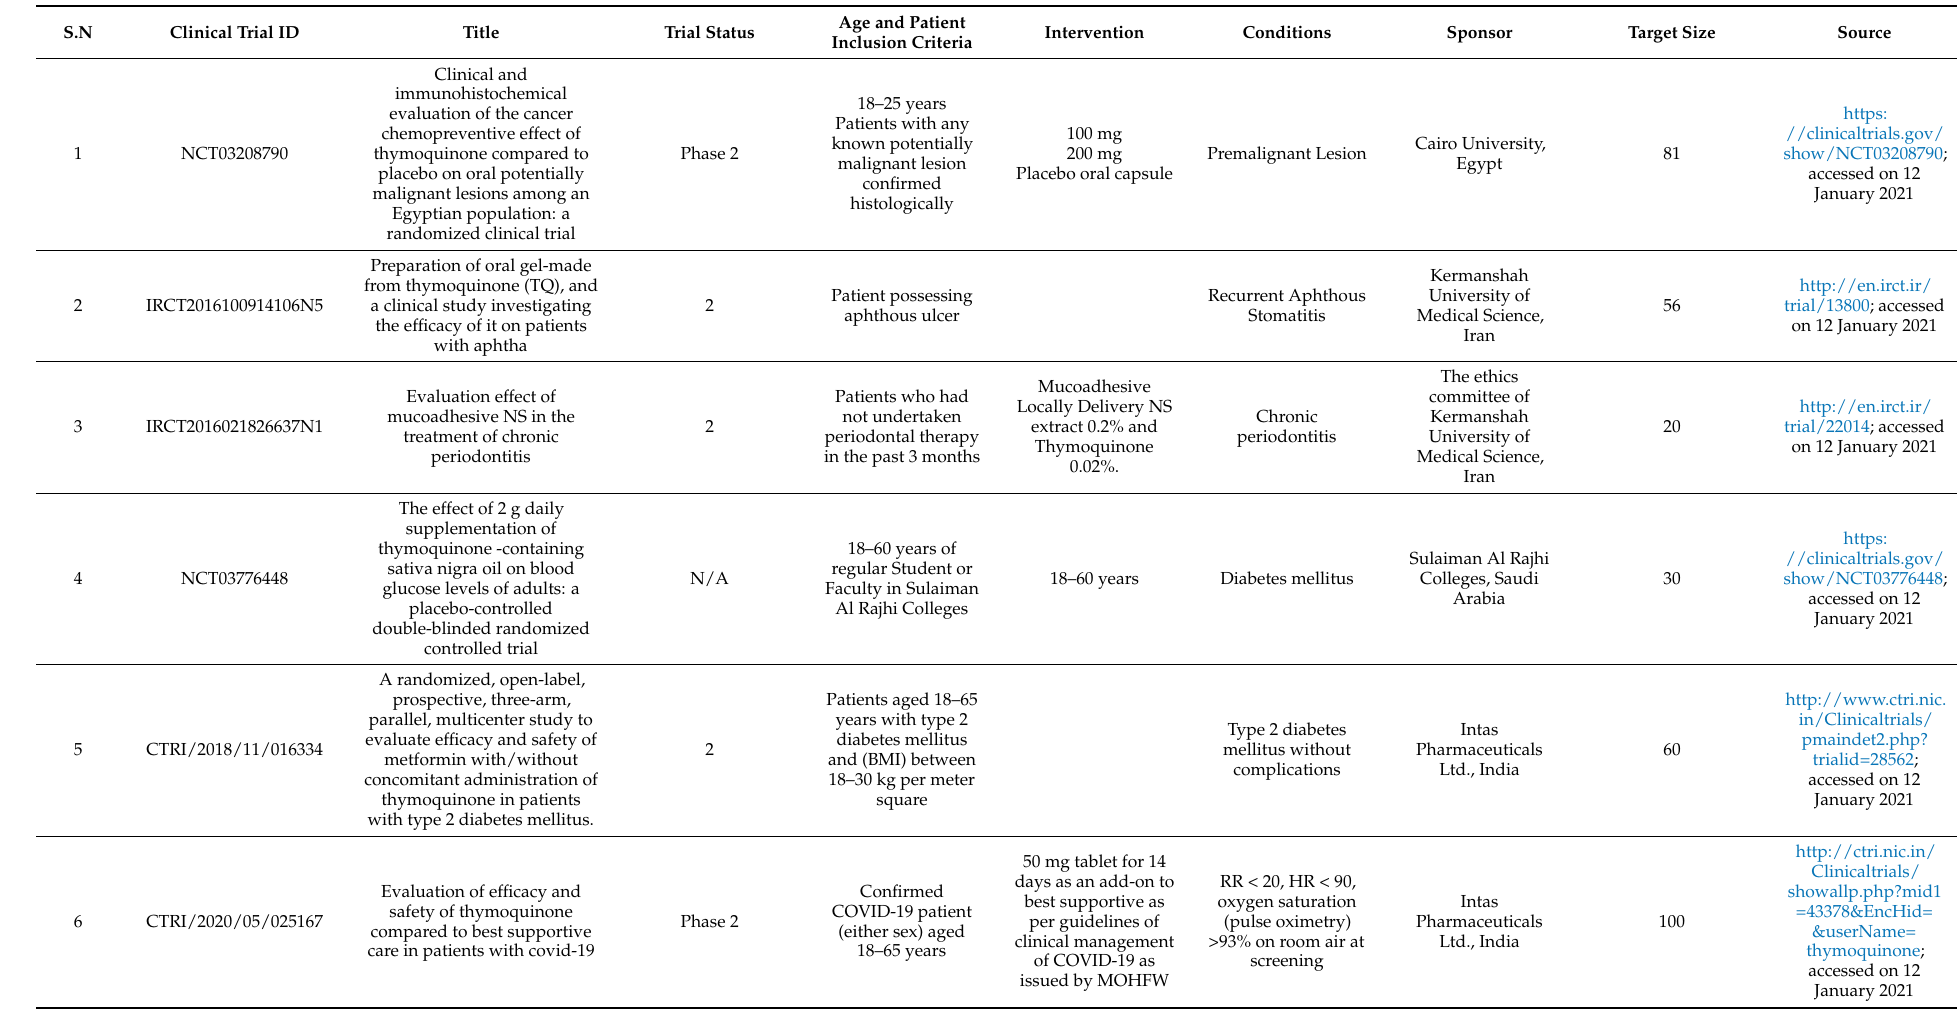
Table 8. Some recent thymoquinone clinical